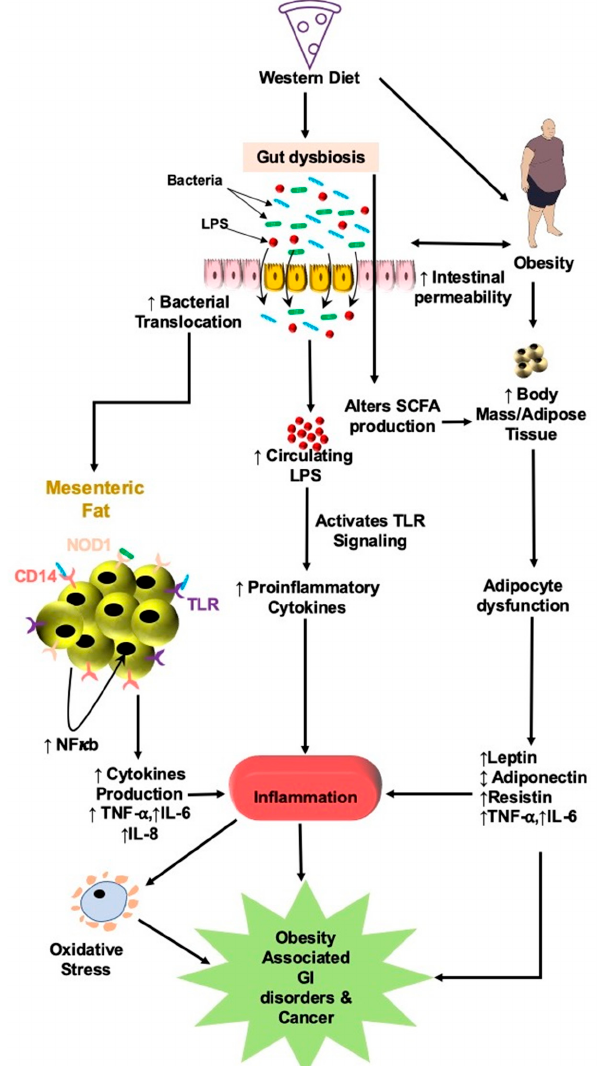
Figure 7. Pathomechanism of GI disorders (CD, UC) and cancer in obesity. The interplay between gut microbiota, adipose tissue, immune system, and intestinal permeability leads to the development of GI disorders and cancer. Dysbiosis increases intestinal permeability and alters SCFAs production. Defective intestinal barrier translocates bacteria into the mesenteric adipose tissue resulting in the production of proinflammatory cytokines. Defective barrier also increases circulating LPS causing inflammation. Adipocyte dysfunction alters adipokine secretion which can participate in low-grade inflammation. Thus, the complex interaction between diet, obesity and dysbiosis creates an inflammatory milieu which predisposes to GI disorders and cancer. LPS, liposaccharide; TLR, toll-like receptor; CD14, cluster of differentiation 14; NOD1, nucleotide binding oligomerization domain containing 1; NF-kB, nuclear factor kappa B; IL-6,8, interleukin; TNF- α , tumor necrosis factor alpha; SCFA, short-chain fatty acid. Upward arrow represents increase; downward arrow represents decrease; double head arrow indicates either increase or